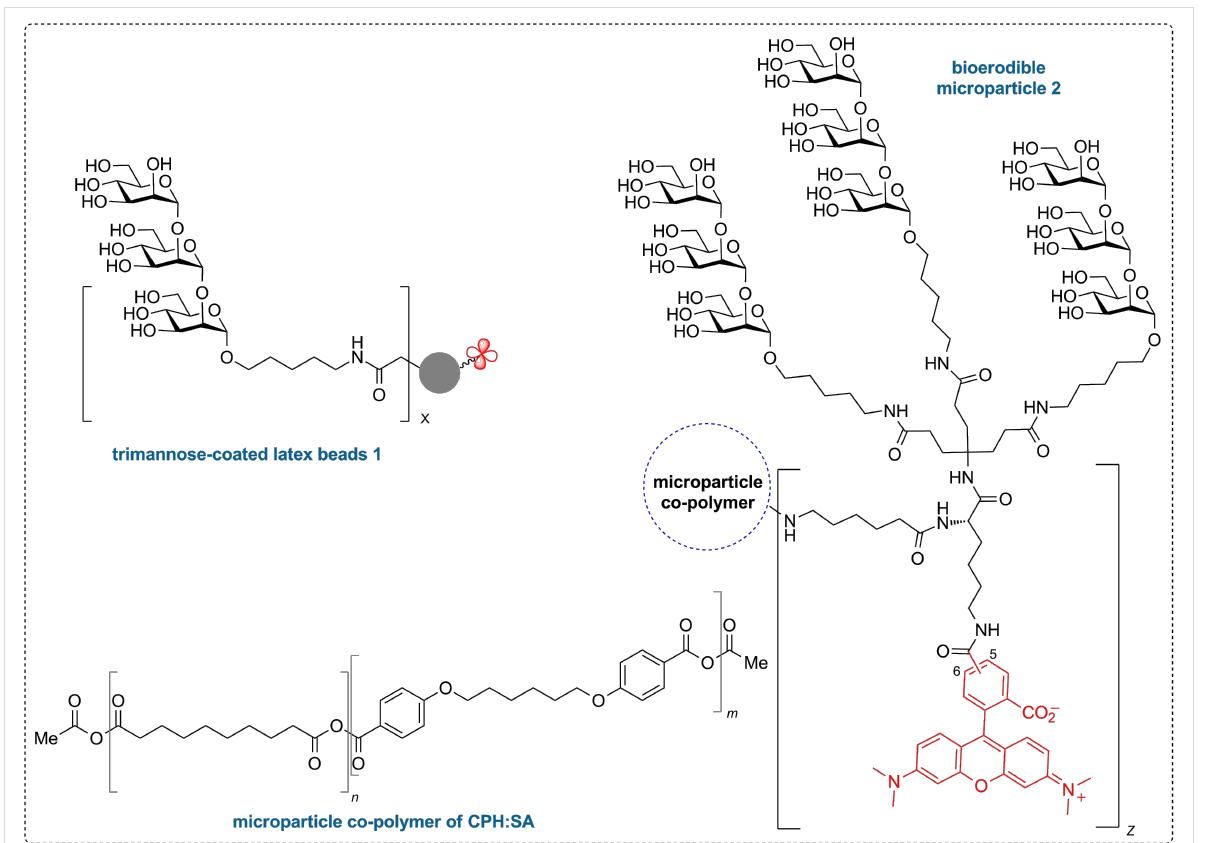
Figure 2: Pathogen-associated bioerodible microparticles 2 and trimannose-coated latex beads 1